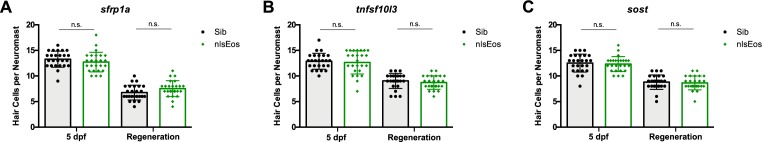
Expression of support cell transgenes does not alter hair cell development or regeneration.(A) Total number of FM 1-43FX-labeled hair cells per neuromast at 5 dpf or following hair cell regeneration (72 hpt) in sfrp1a:nlsEos fish (nlsEos) and non-transgenic siblings (Sib). 5 dpf: 13.28 ± 1.32 (Sib) vs. 12.72 ± 1.93 (nlsEos), n = 25 neuromasts each (5 fish each); Regeneration: 6.76 ± 1.55 (Sib) vs. 7.52 ± 1.56 (nlsEos), n = 25 neuromasts each (5 fish each); mean ± SD; Mann Whitney U test, p=0.1414 (5 dpf), p=0.0658 (Regeneration). (B) Total number of FM 1-43FX-labeled hair cells per neuromast at 5 dpf or following hair cell regeneration (72 hpt) in tnfsf10l3:nlsEos fish (nlsEos) and non-transgenic siblings (Sib). 5 dpf: 12.88 ± 1.56 (Sib) vs. 12.64 ± 2.25 (nlsEos), n = 25 neuromasts each (five fish each); Regeneration: 9.04 ± 1.49 (Sib) vs. 8.72 ± 1.31 (nlsEos), n = 25 neuromasts each (five fish each); mean ± SD; Mann Whitney U test, p=0.9338 (5 dpf), p=0.2722 (Regeneration). (C) Total number of FM 1-43FX-labeled hair cells per neuromast at 5 dpf or following hair cell regeneration (72 hpt) in sost:nlsEos fish (nlsEos) and non-transgenic siblings (Sib). 5 dpf: 12.52 ± 1.76 (Sib) vs. 12.32 ± 1.46 (nlsEos), n = 25 neuromasts each (five fish each); Regeneration: 8.80 ± 1.41 (Sib) vs. 8.64 ± 1.35 (nlsEos), n = 25 neuromasts each (five fish each); mean ± SD; Mann Whitney U test, p=0.4527 (5 dpf), p=0.5396 (Regeneration).10.7554/eLife.43736.009Figure 2—figure supplement 3—source data 1.Expression of support cell transgenes does not alter hair cell development or regeneration